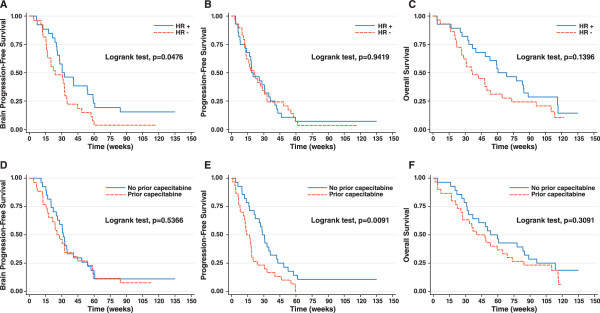
Kaplan-Meier estimates for (A) brain PFS by hormone receptor (HR) status; (B) PFS by hormone receptor (HR) status; (C) OS by hormone receptor (HR) status; (D) brain PFS by prior capecitabine; (E) PFS by prior capecitabine; and (F) OS by prior capecitabine in patients with brain metastasis on entry.